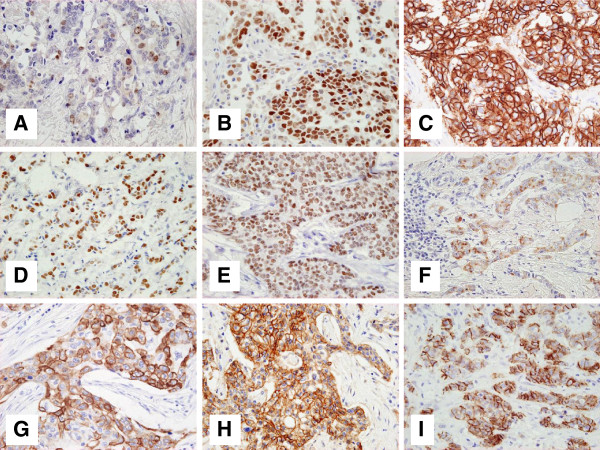
Representative images of immunostaining for 9 molecular markers.A, Positive nuclear Ki67 staining. The Ki67 labeling index of this specimen is 12%. B, p53 staining in the nucleus. This tumor was scored as p53-positive. C, Positive HER2 membrane staining. The HER2 expression of this tumor was scored as 3+. D, Positive nuclear FOXA1 staining. This tumor was classified as FOXA1-positive. E, Positive nuclear GATA3 staining. This tumor was classified as GATA3-positive. F, Positive CK5/6 membrane or sub-membrane staining of tumor cells. This tumor was classified as CK5/6-positive. G, Positive CK14 membrane or sub-membrane staining of tumor cells. This tumor was classified as CK14-positive. H, Positive EGFR membrane staining of tumor cells. The EGFR expression of this tumor was scored as 3+. I, Positive P-cadherin membrane or sub-membrane immunoreactivity of tumor cells. This tumor was classified as P-cadherin-high. The magnification of all figures is ×400.